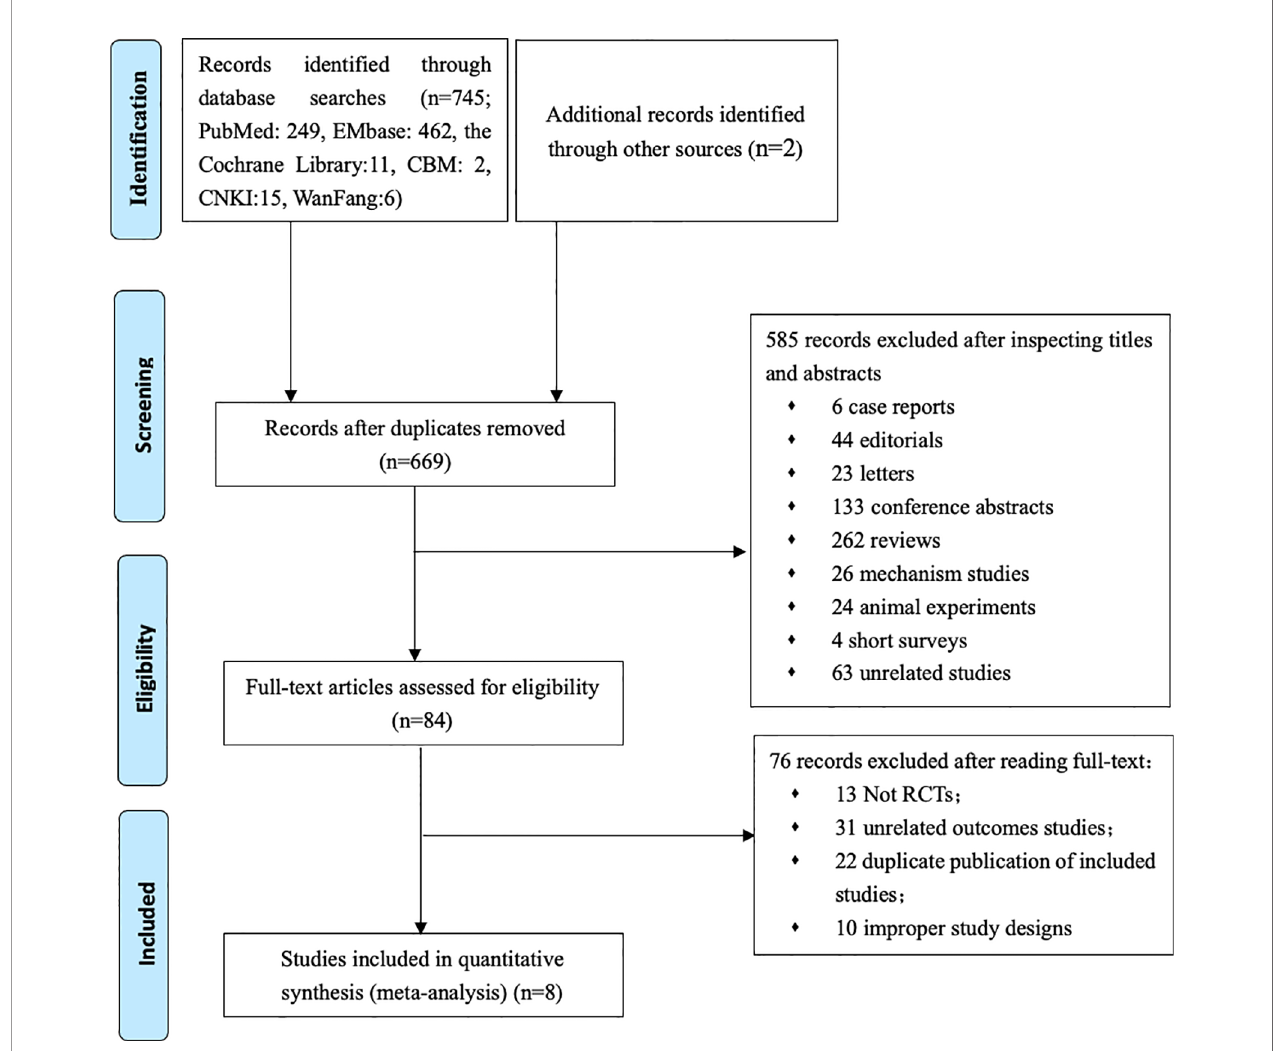
FIGURE 1 | Flow chart of study